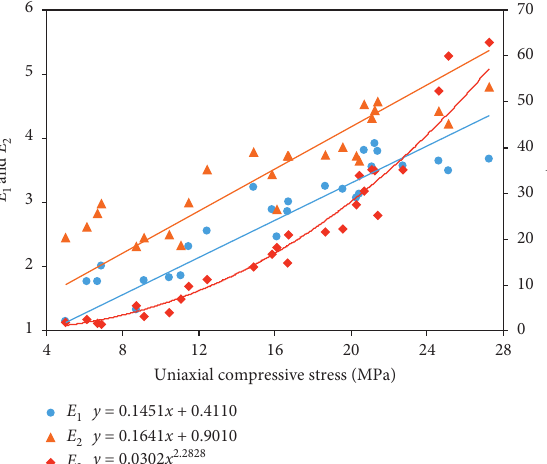
1 , E 2 , and E 3 versus the UCS of 27 coal